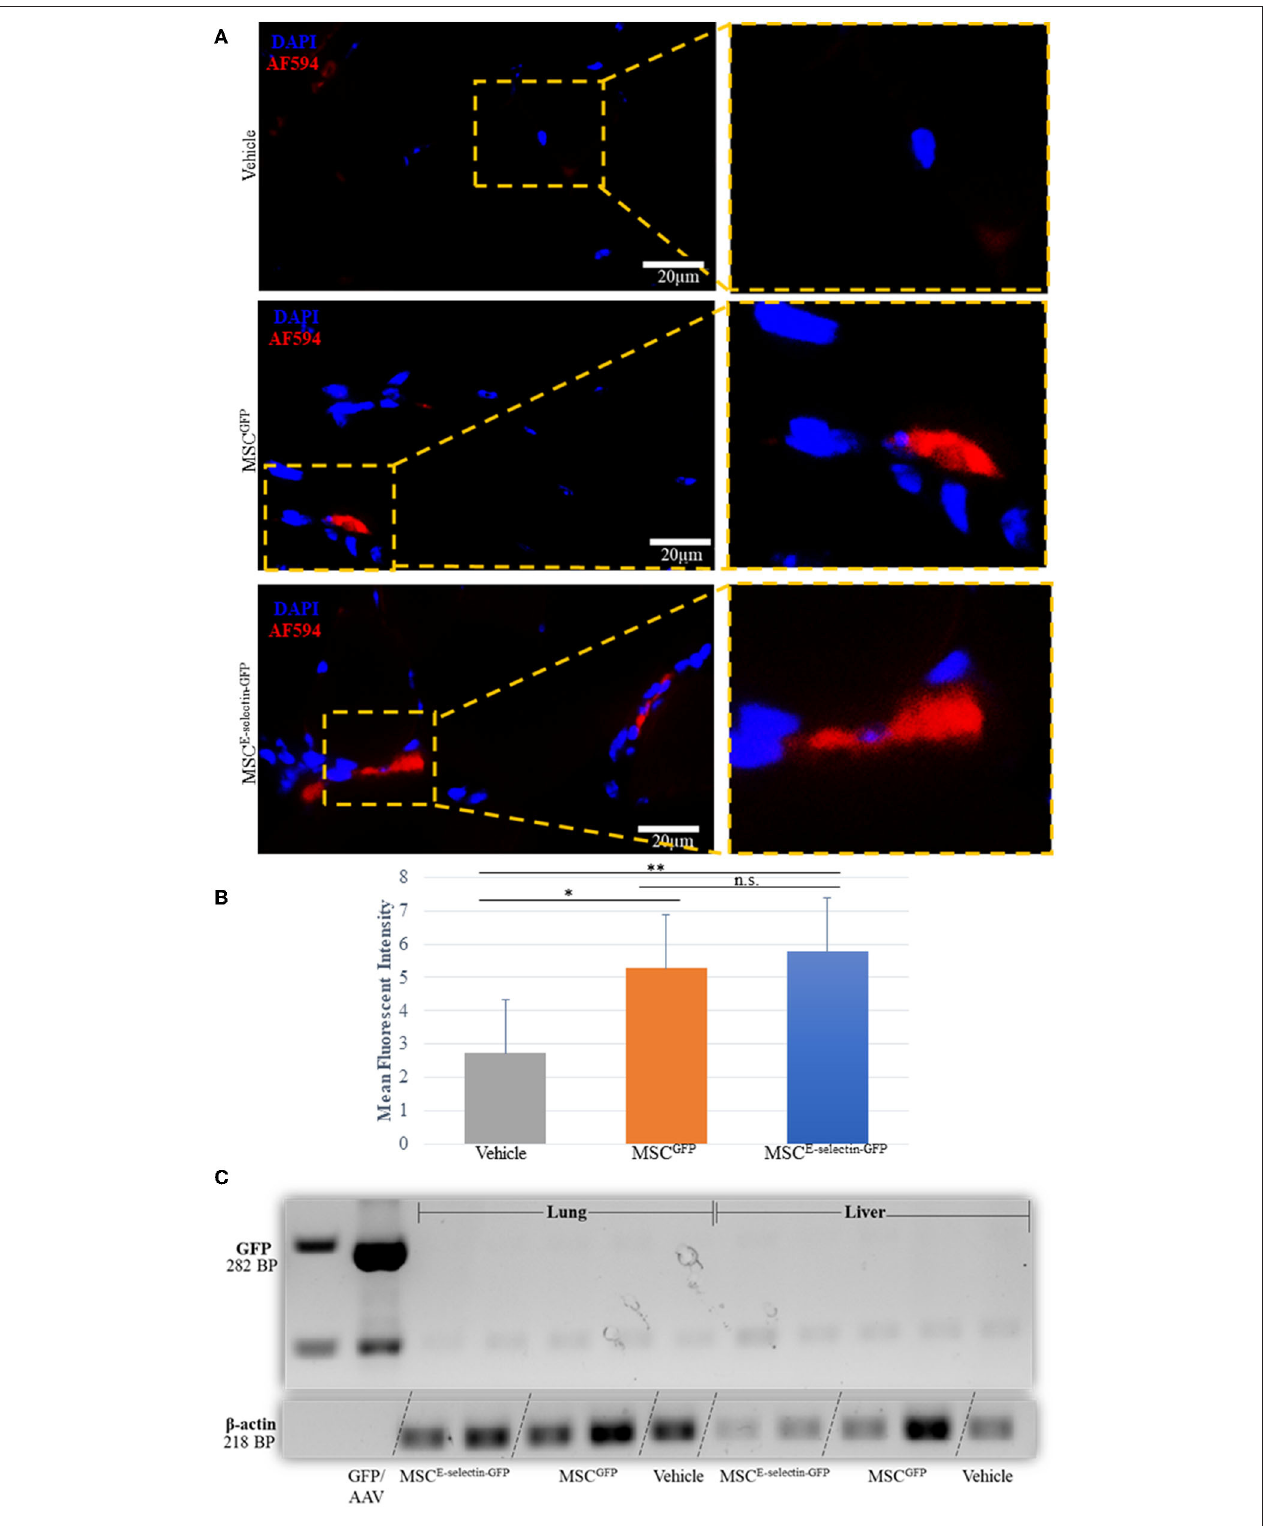
FIGURE 7 | Determining the fate of MSC injected as treatment for hindlimb ischemia 3-weeks after injection into thigh muscle. (A) . Representative images of immunohistochemistry co-staining with DAPI and GFP (AF-594), demonstrating that a few of the injected MSC survive at 3-weeks (POD 21). (B) Quantitative analysis of mean fluorescent intensity (MFI) in ischemic thigh muscle tissue sections stained for GFP demonstrates significant increased MFI between MSC E − selectin − GFP,